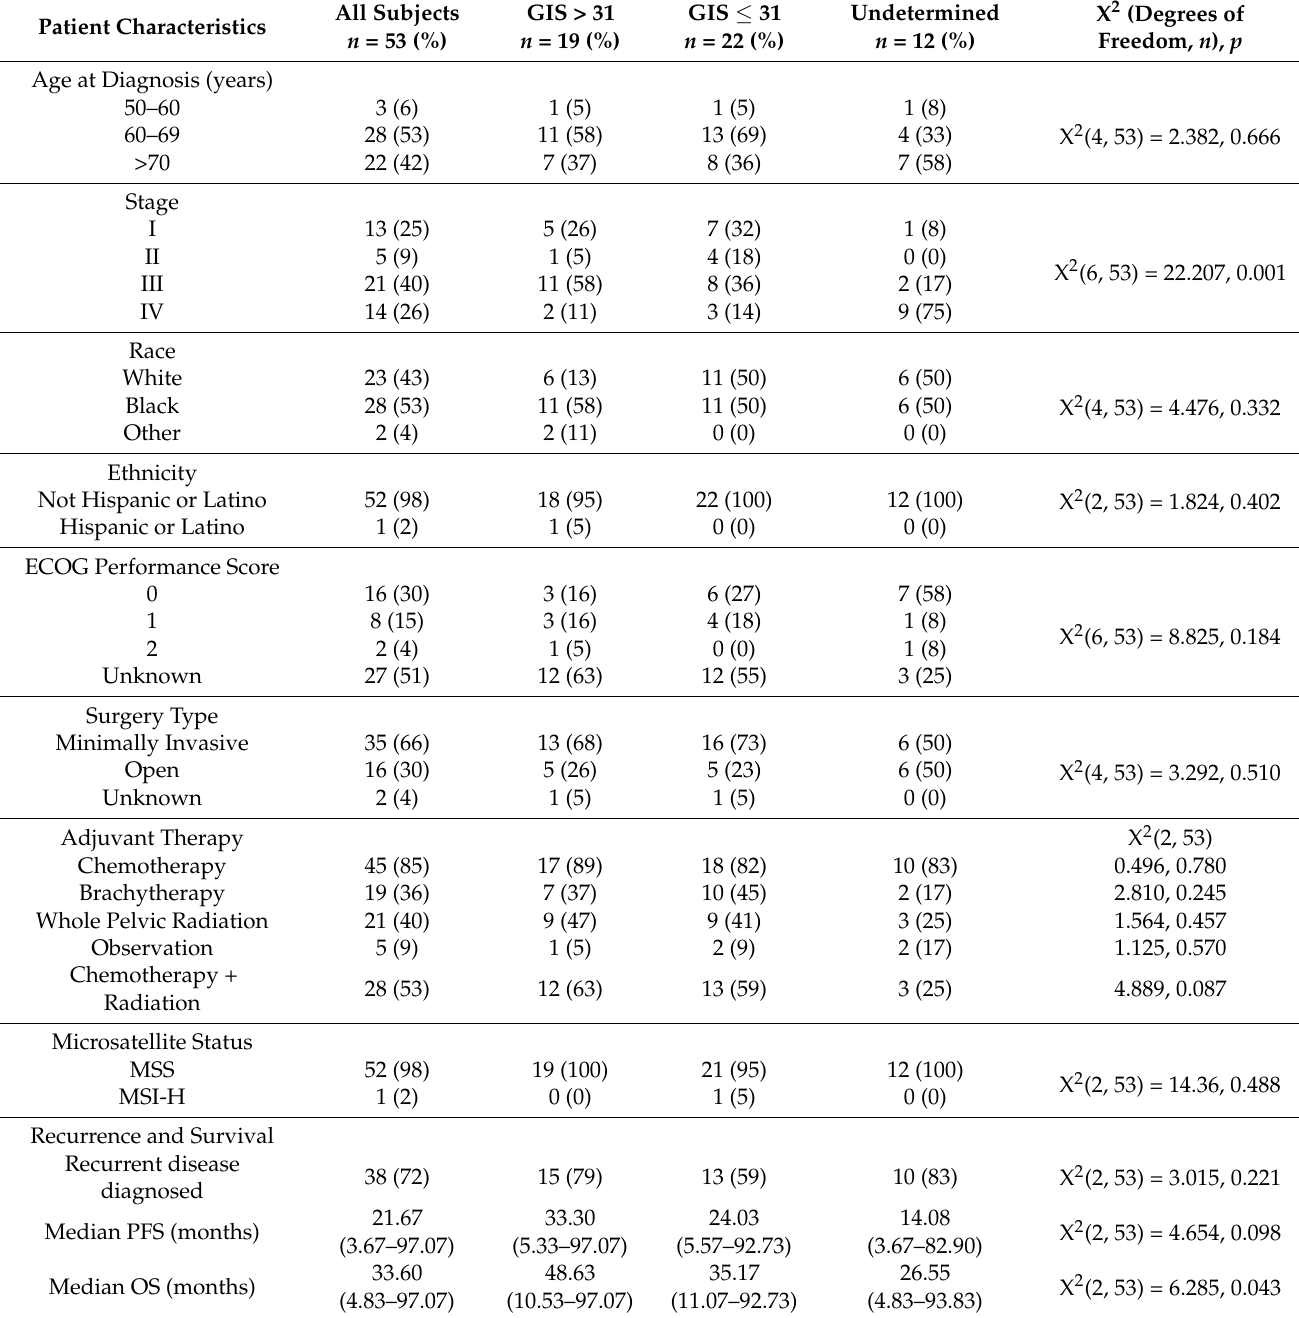
Table 1. Clinical characteristics of patient diagnosed with uterine serous carcinoma. MSS (microsatel- lite stable), MSI-H (microsatellite instability-high), GIS (genomic instability score), PFS (progression- free survival), OS (overall survival), ECOG (European Cooperative Oncology